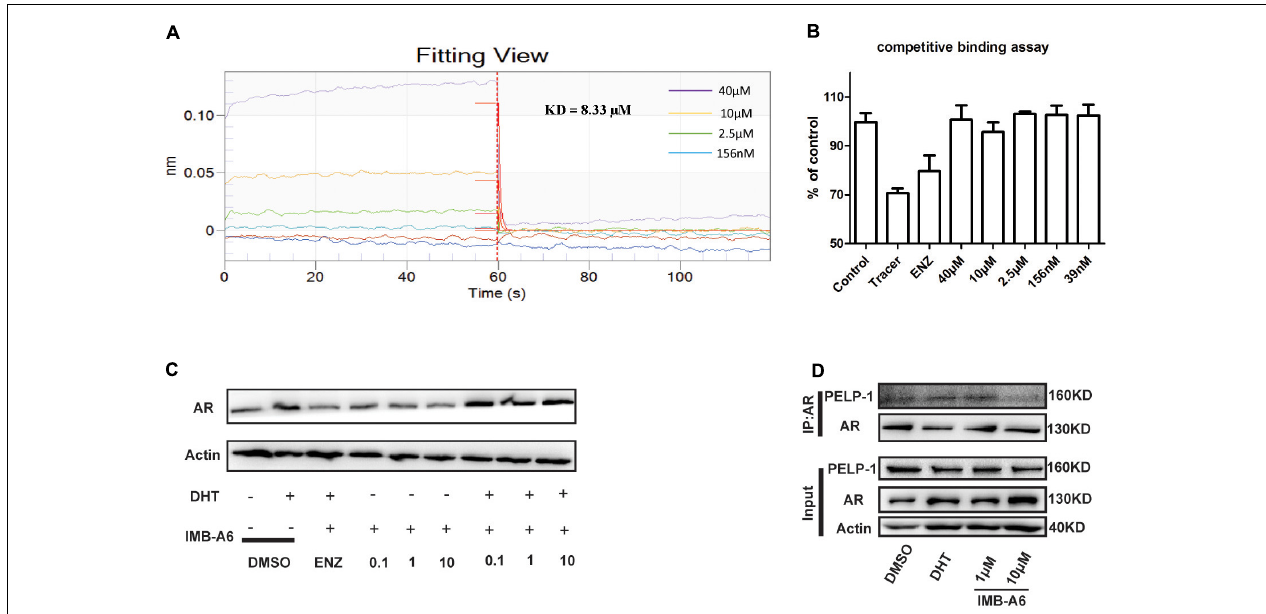
FIGURE 4 | IMB-A6 inhibits AR activity through binding to AF2 site. (A) The Octet binding assay using biotinylated AR-LBD on superstreptavidin sensors and IMB-A6 indicated IMB-A6 bound directly to AR. (B) Competitive binding of IMB-A6 to the AR-LBD evaluated by AR fluorescence polarization (FP) assay showed that IMB-A6 did not bind to the HBP site. (C) Western blot analysis indicated that IMB-A6 did not suppress AR protein expression in LNCaP cells at 1 and 10 µ M. (D) IMB-A6 significantly disrupted the interaction between AR and PELP-1 at 10 µ M as a result of Co-immunoprecipitation